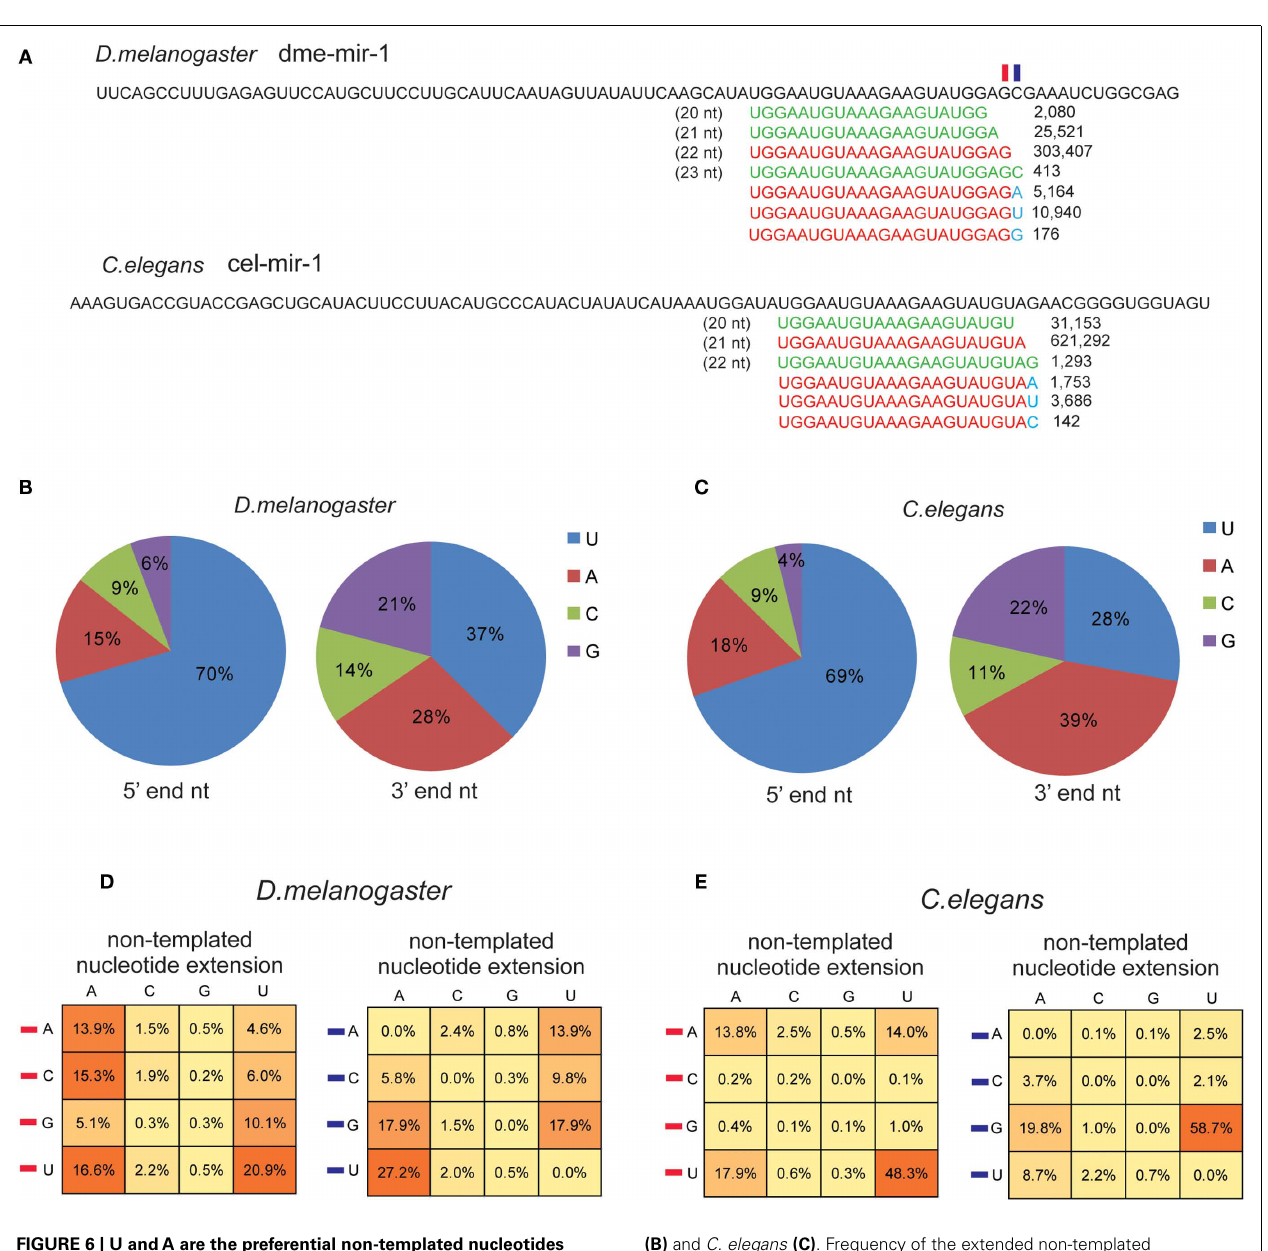
FIGURE 6 | U andA are the preferential non-templated nucleotides added to mature miRNAs. (A) Both D. melanogaster and C. elegans miR-1 miRNAs contain non-templated nucleotide (marked in blue) extension at 3 (cid:2) end.The frequency of the four types of 5 (cid:2) and 3 (cid:2) nucleotides based on corrected authentic miRNA sequences in D. melanogaster